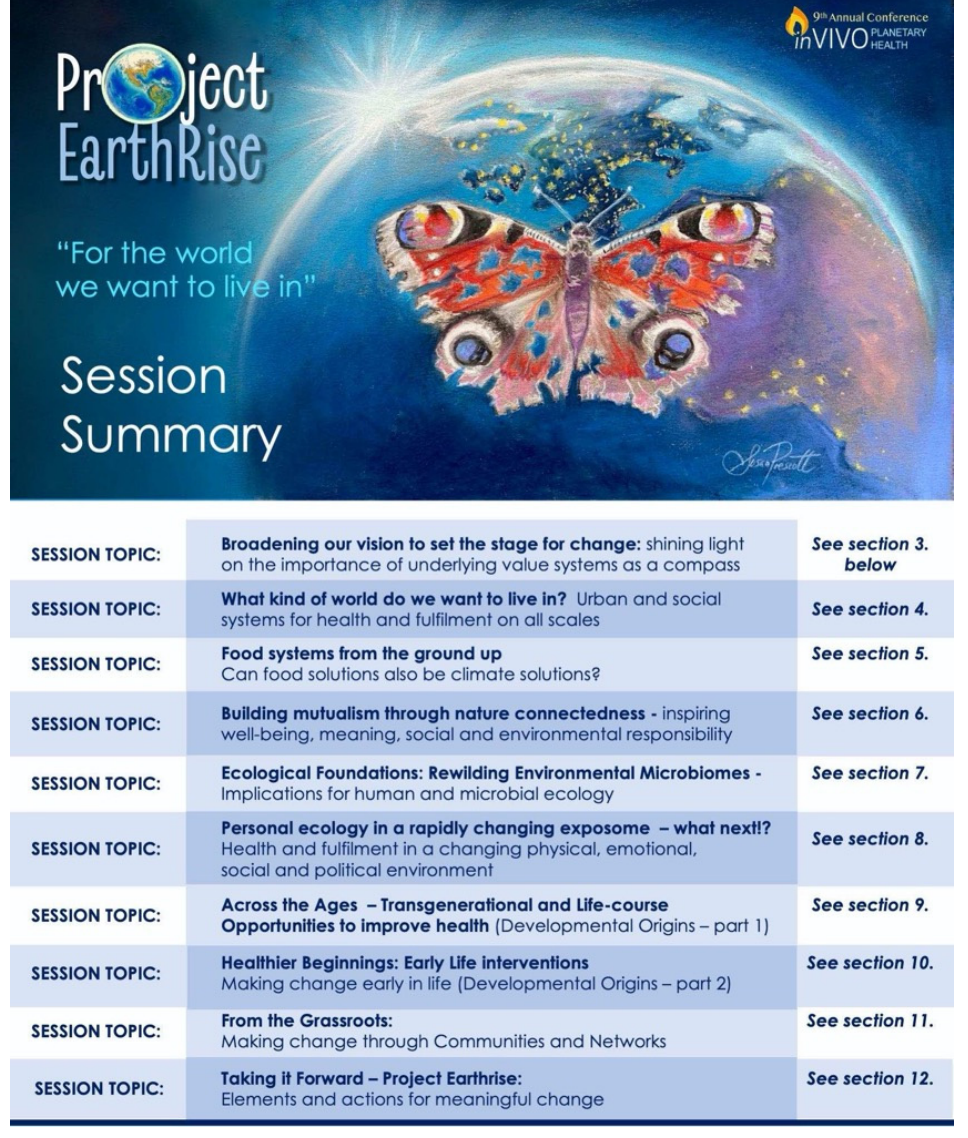
Figure 1. Overview of the sessions presented within the initial Project Earthrise discussions at our annual conference (and the corresponding sections of these proceedings).